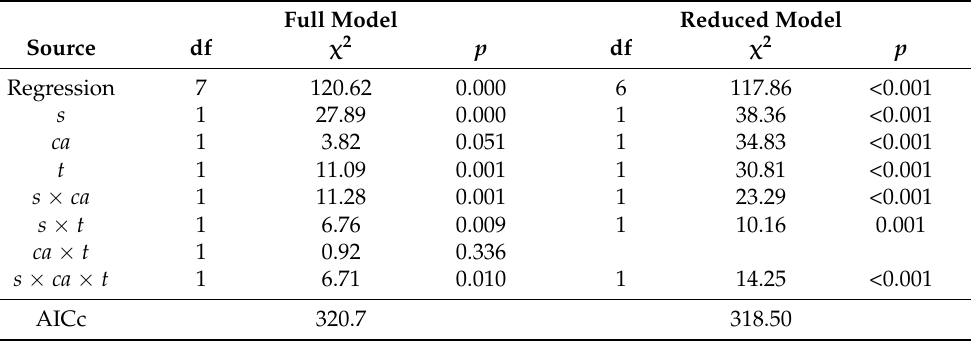
Table 4. ANOVA and Anderson ‐ Darling residual normality tests of bird population density census data, pairs/ km? . Significant F test triggered Bonferroni pairwise means comparisons in Figure 6a, separate for each bird species.